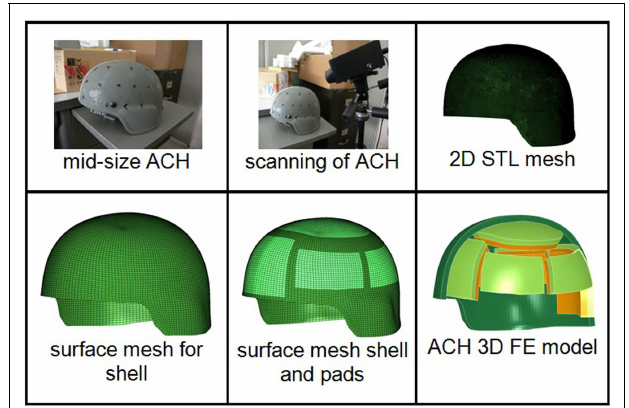
FIGURE 1 | Step by step procedure for developing a 3D FEACH model